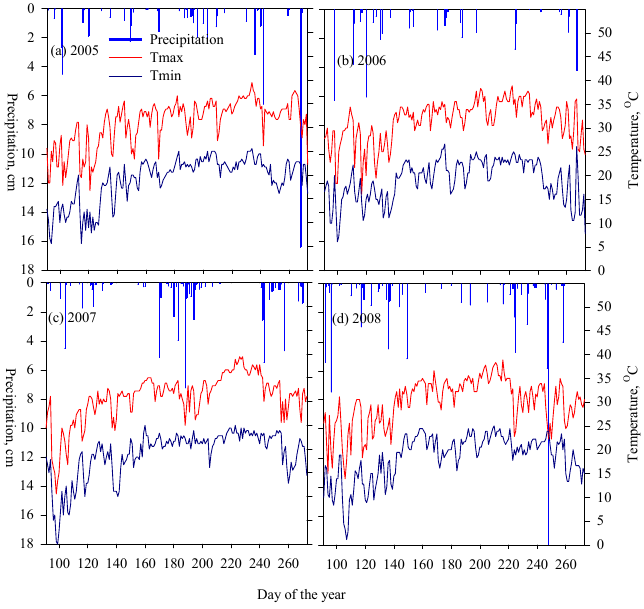
Figure 1. Weather recorded at Stoneville, Mississippi during the crop seasons (April–September) of 2005 ( a ), 2006 ( b ), 2007 ( c ), and 2008 ( d ): maximum and minimum temperature and precipitation. Table 2. Cotton growing season weather in 2005, 2006, 2007, and 2008: monthly mean daily minimum (Tmin) and maximum temperature (Tmax), and monthly total precipitation.